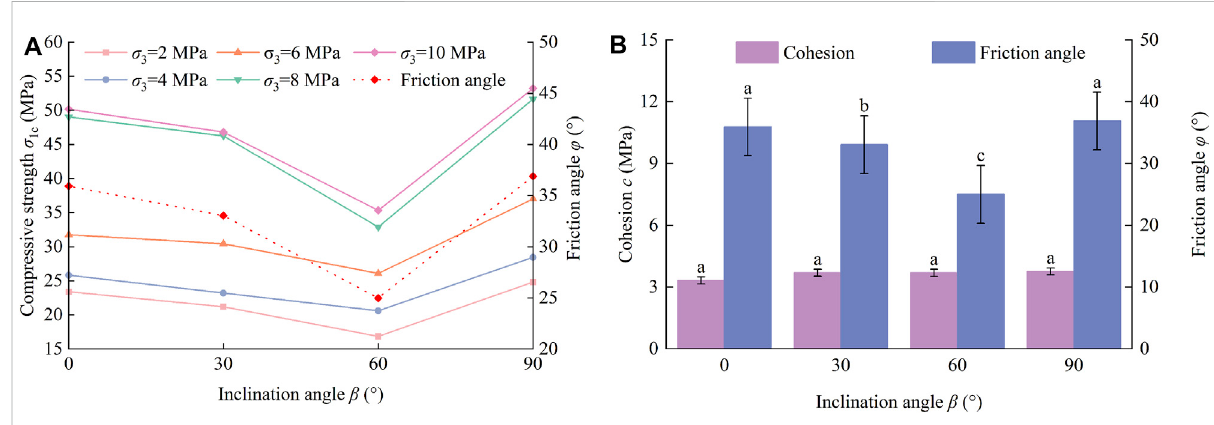
FIGURE 5 (A) Analysisofin fl uenceofinclinationangleonshearstrengthparameters; (B) Variationsofcompressivestrengthandinternalfrictionanglewith inclination angle.